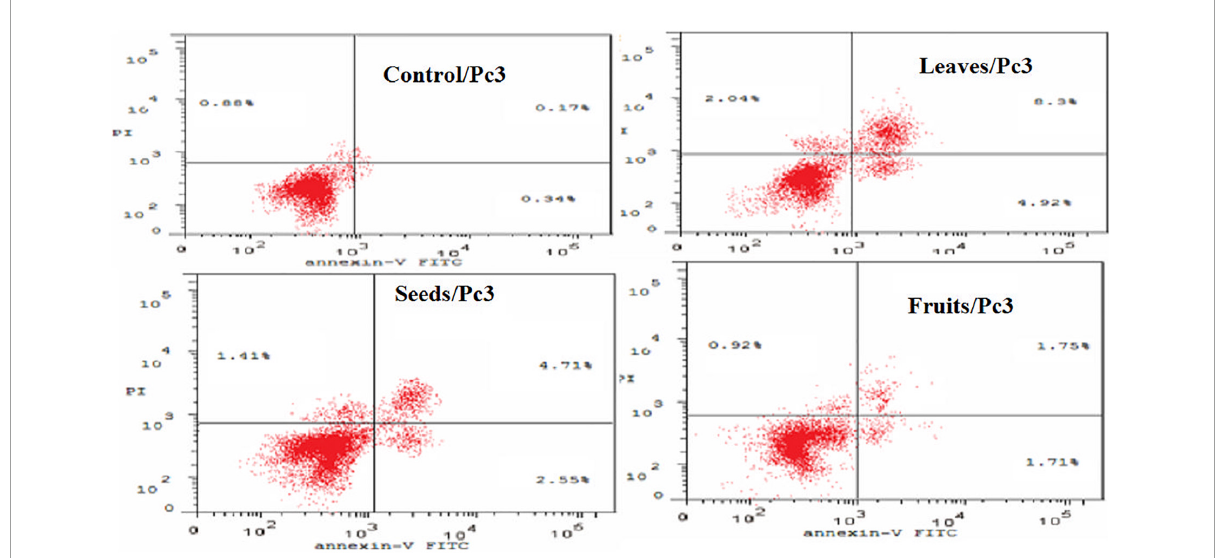
FIGURE6 Induction of apoptosis after treatment of Pc3 cells with leaf, seed, and fruit extracts separately in comparison with control.